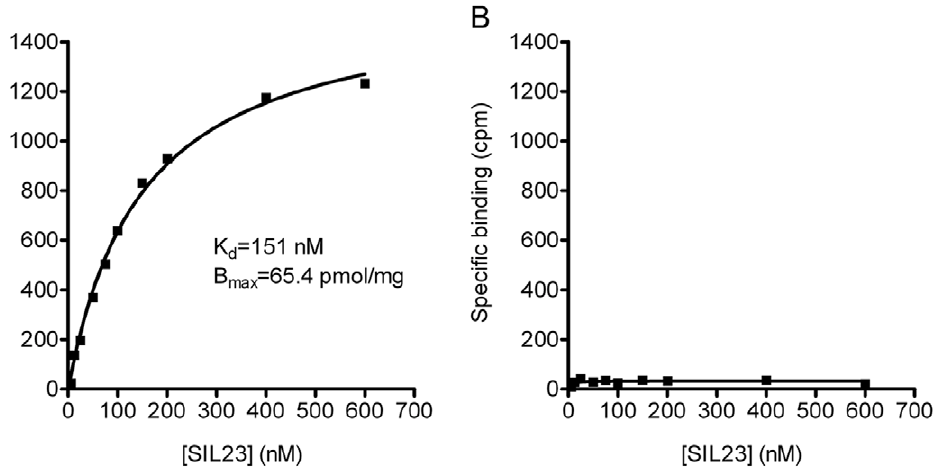
Figure 7. [ 125 I]SIL23 binding sites are present at high density in a transgenic A53T a -syn mouse model for PD. [ 125 I]SIL23 binding was determined in mouse brain samples obtained from ( A ) M83 mice with transgenic expression of human A53T a -syn, and ( B ) M7 mice with transgenic expression of human WT a -syn. Representative plots of specific binding versus [ 125 I]SIL23 concentration are shown. The data was analyzed by curve fitting to a one-site binding model using nonlinear regression. [ 125 I]SIL23 binding was detected in M83 brain samples with a K d of 150.3 nM and a B max of 65 pmol/mg insoluble protein. No significant [ 125 I]SIL23 binding was detected in M7 brain. The results were verified with two independent